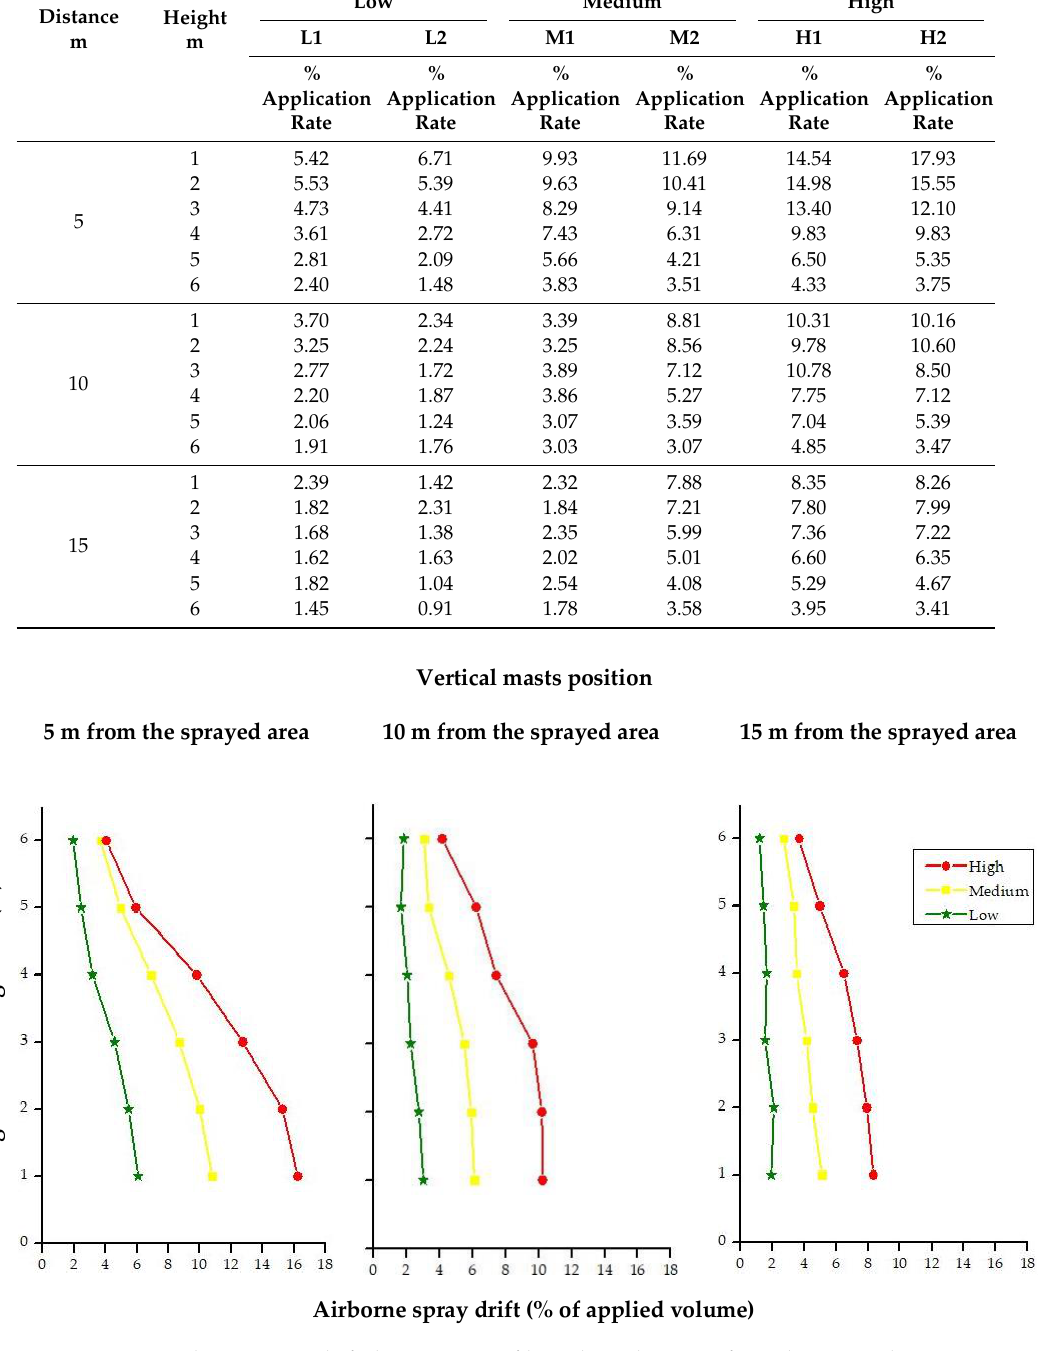
Figure 7. Airborne spray drift deposition profile at three distances from the sprayed area.